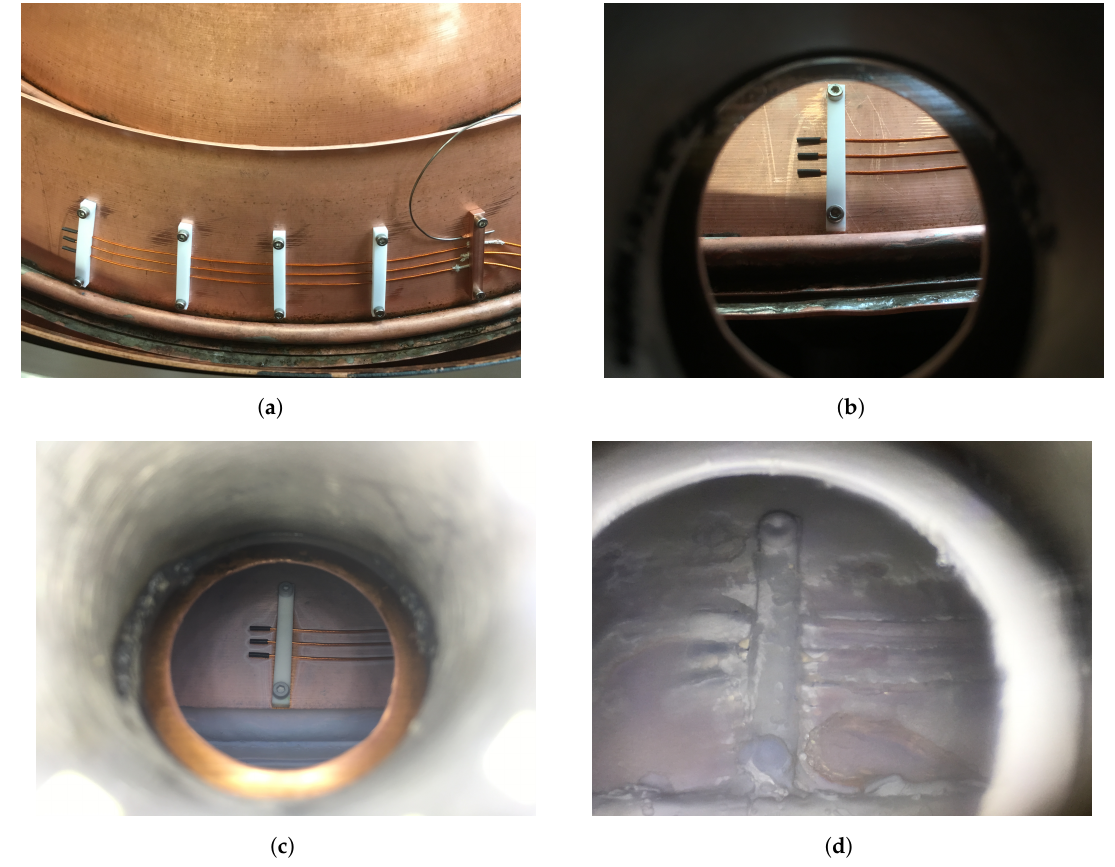
Figure 12. Electrodes under long-term testing. In ( a ) the electrodes installed inside the equipment are shown, in ( b ) the window for visualization, and in ( c ) and ( d ) different icing